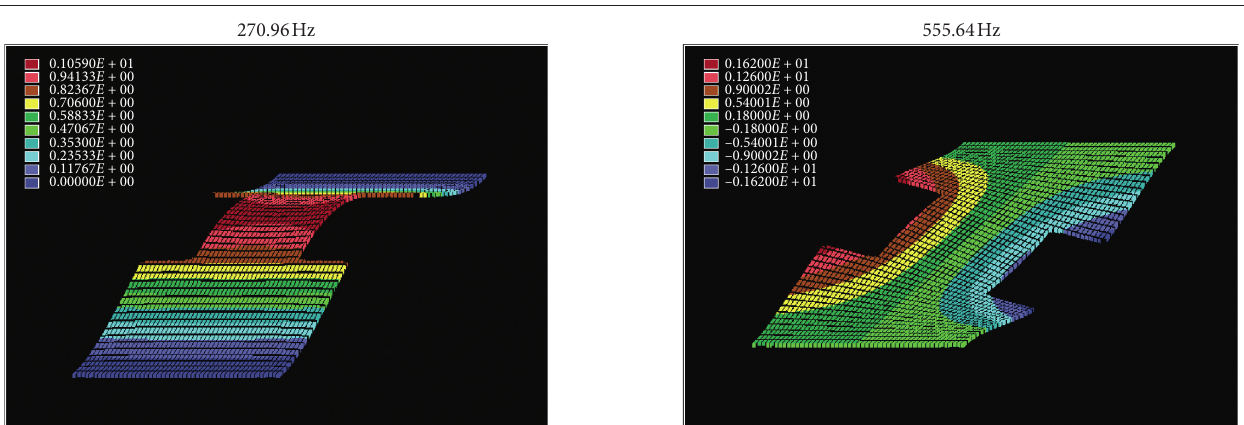
Table 19: R -functions method: mode shapes and natural frequencies (Case